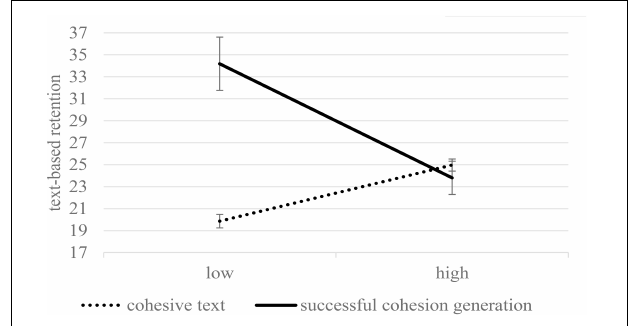
FIGURE 5 | Text-based representation (collapsed across immediate and delayed testing) as a function of condition and the level of reading skill (estimated means and standard errors for –1 SD and +1 SD). Only learners who successfully generated (+1 SD) were analyzed. Maximum performance was 38.